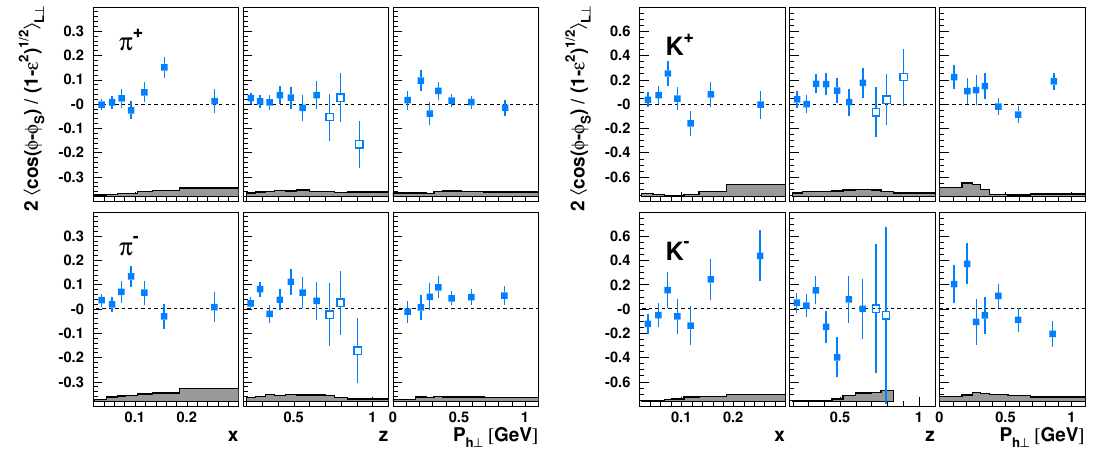
√ Figure 21 . The 2 h cos( φ − φ S ) / 1 − (cid:15) 2 i h amplitudes for charged mesons (left: pions; right: kaons) L ⊥ presented either in bins of x , z , or P h ⊥ . Data at large values of z , marked by open points in the z projection, are not included in the other projections. Systematic uncertainties are given as bands, not including the additional scale uncertainty of 8.0% due to the precision in the determination of the target and beam